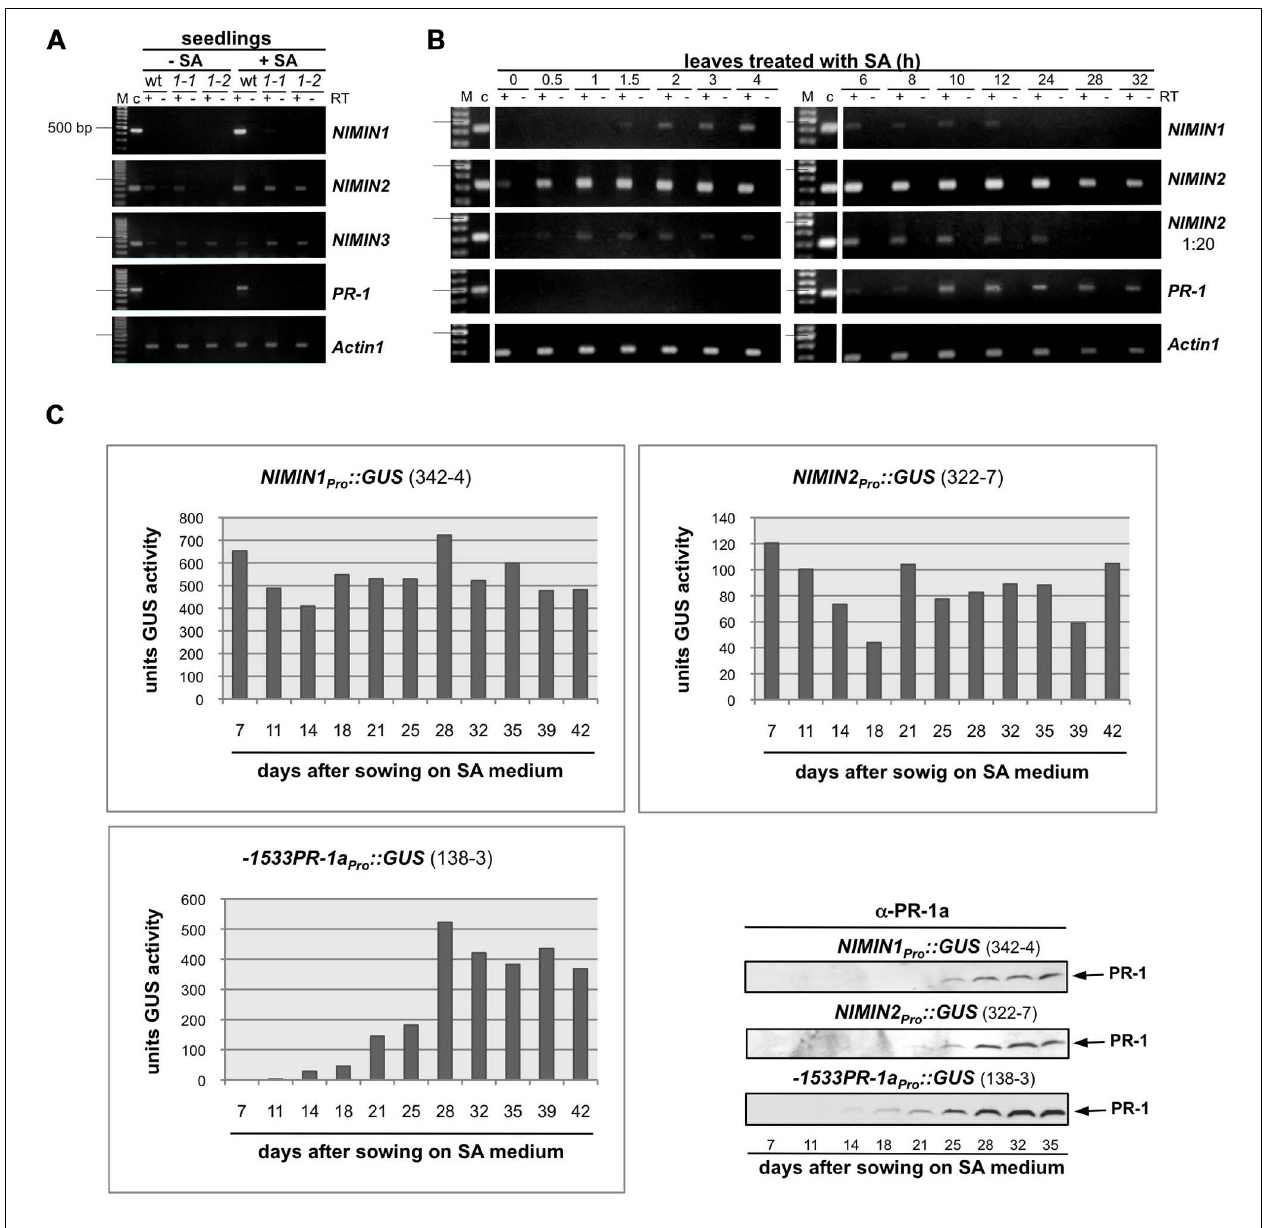
FIGURE 2 | Salicylic acid-induced Arabidopsis NIMIN1 and NIMIN2 are expressed differentially from each other and from PR-1 . RNA samples were isolated from Arabidopsis seedlings or Arabidopsis leaves and analyzed as described in Figure 1A . Expression of NIMIN1 and NIMIN2 is compared to expression of NIMIN3 and PR-1 . (A) RT-PCR analyses of RNAs from wild-type (Col-0) and npr1-1 and npr1-2 mutant seedlings. 1-1, npr1-1 ; 1-2, npr1-2 . (B) RT-PCR analyses of RNAs from leaf tissue at different times after spraying plants with 1 mM SA. (C) Time course of SA-induced GUS reporter enzyme